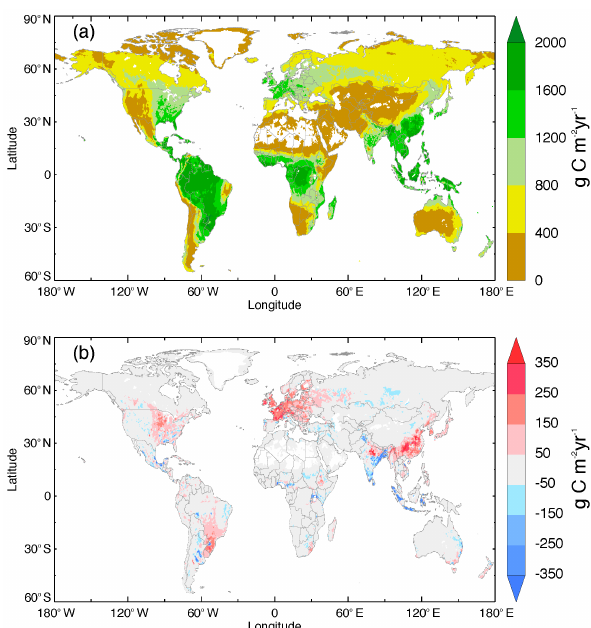
Figure 6. Modelled mean grassland NPP (NPP model ) for the period 1990–1999 (a) , and the NPP differences (b) between NPP model and NPP from unmanaged grassland only. NPP model combines grass- land productivity of all PFTs (Sect. 2.5), accounting for the variable fractions of grazed, mown, and unmanaged grassland in each grid cell calculated by Eqs. (4)–(11). Figure 7. (a) Comparison between site observations of whole-